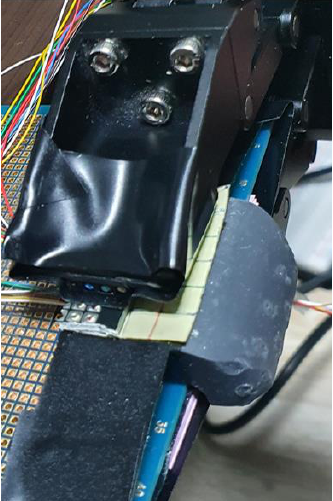
Figure 8. Structure for conversion of contact.